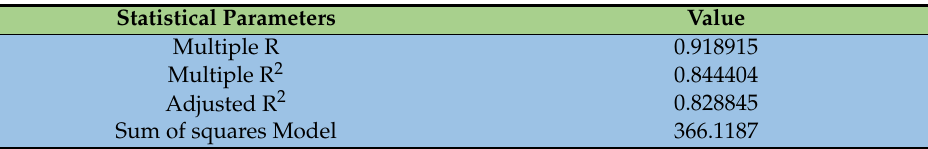
Table 4. Results of the relevant statistical parameters obtained from the Nano-QSTR regression model for